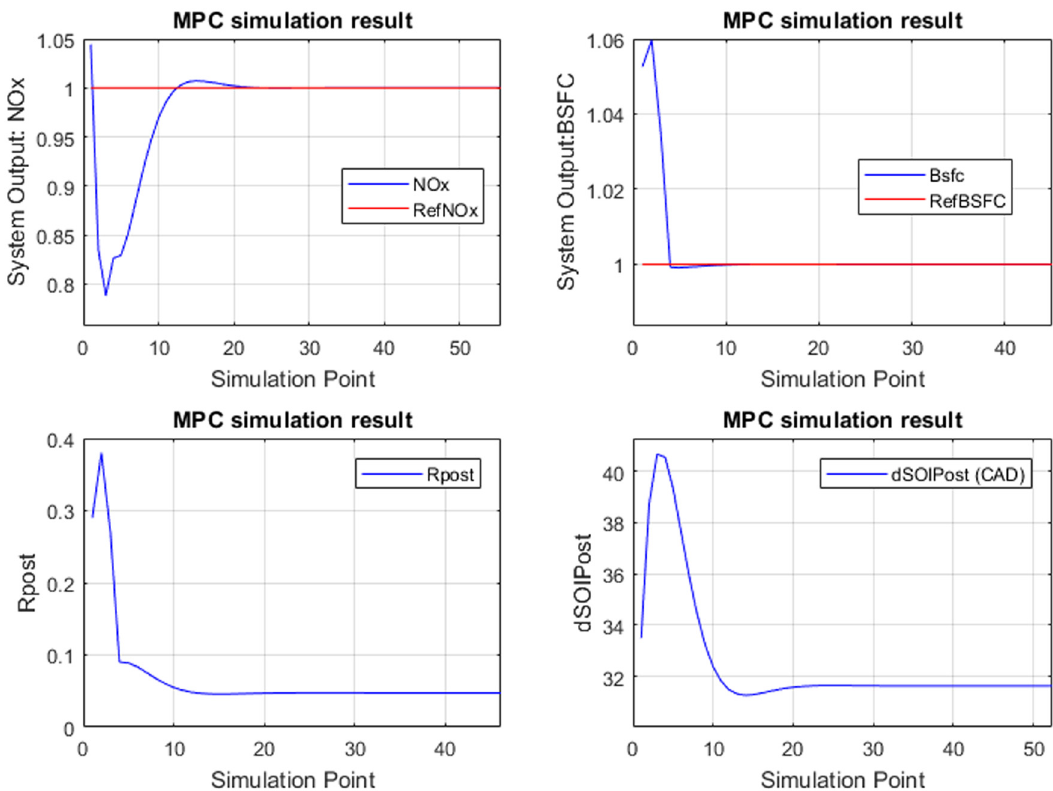
Figure 5: MPC simulation result with Hildreth ’ s